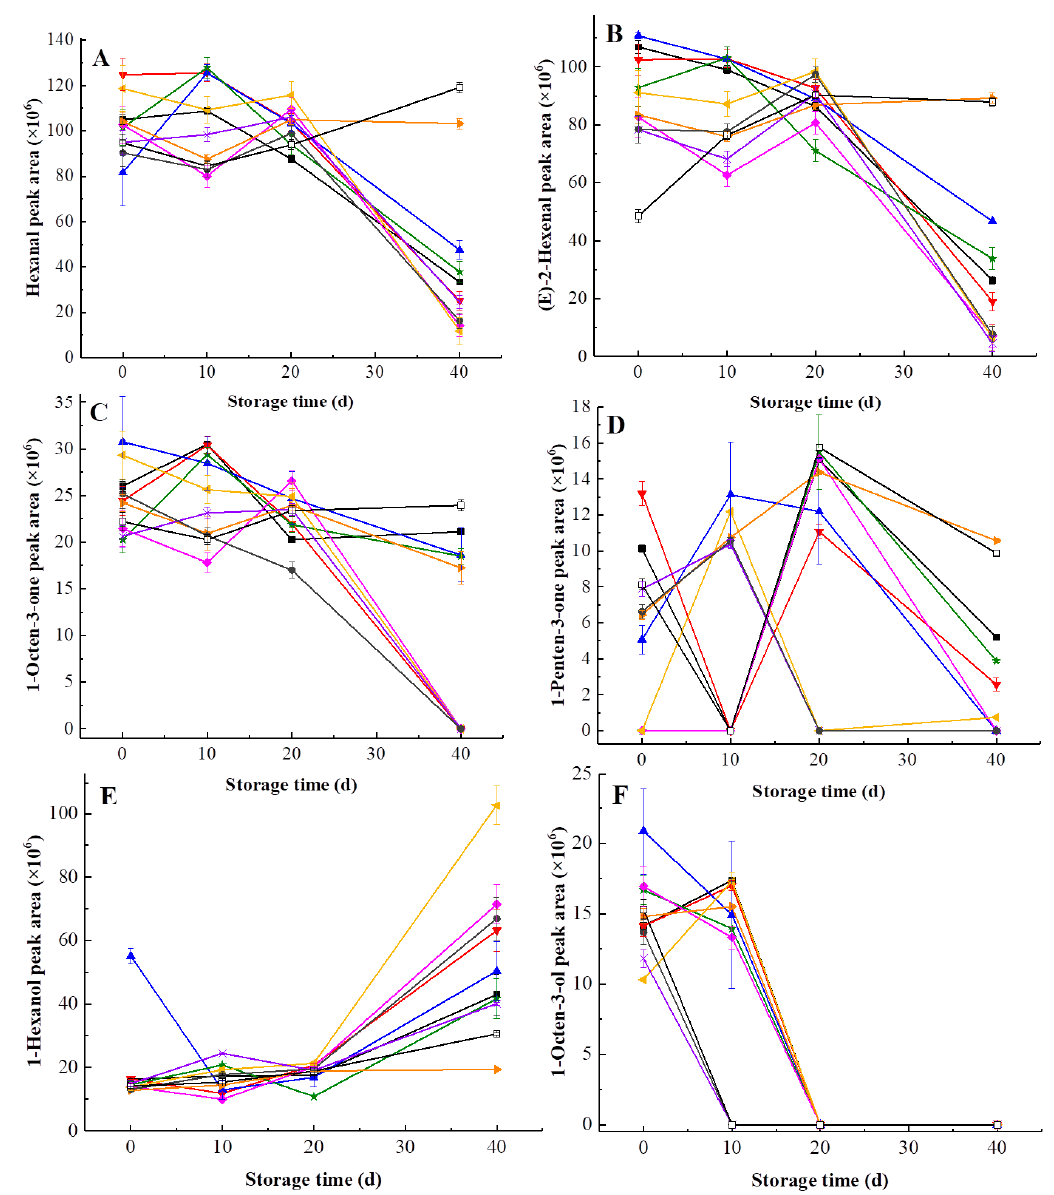
Figure 7. Changes of main volatiles in heat-treated and HHP-treated kiwifruit pulp beverage during storage at 4 °C for 40 days. ( A ) Hexanal content; ( B ) (E) -2-hexenal content; ( C ) 1-octen-3-one content; ( D ) 1-penten-3-one; ( E ) 1-hexanol content; ( F ) 1-octen-3-ol content. Heat treatment (85 °C for 10 min) ( ■ ), HHP (high hydrostatic pressure, 400-600 MPa for 5-15 min): 400 MPa/5 min ( ▼ ), 400 MPa/10 min ( ▲ ), 400 MPa/15 min ( ★ ), 500 MPa/5 min ( ◆ ), 500 MPa/10 min ( ◀ ), 500 MPa/15 min ( ▶ ), 600 MPa/5 min ( × ), 600 MPa/10 min ( ● ), 600 MPa/15 min ( □ ). All data were expressed as means ± SD, n = 3.